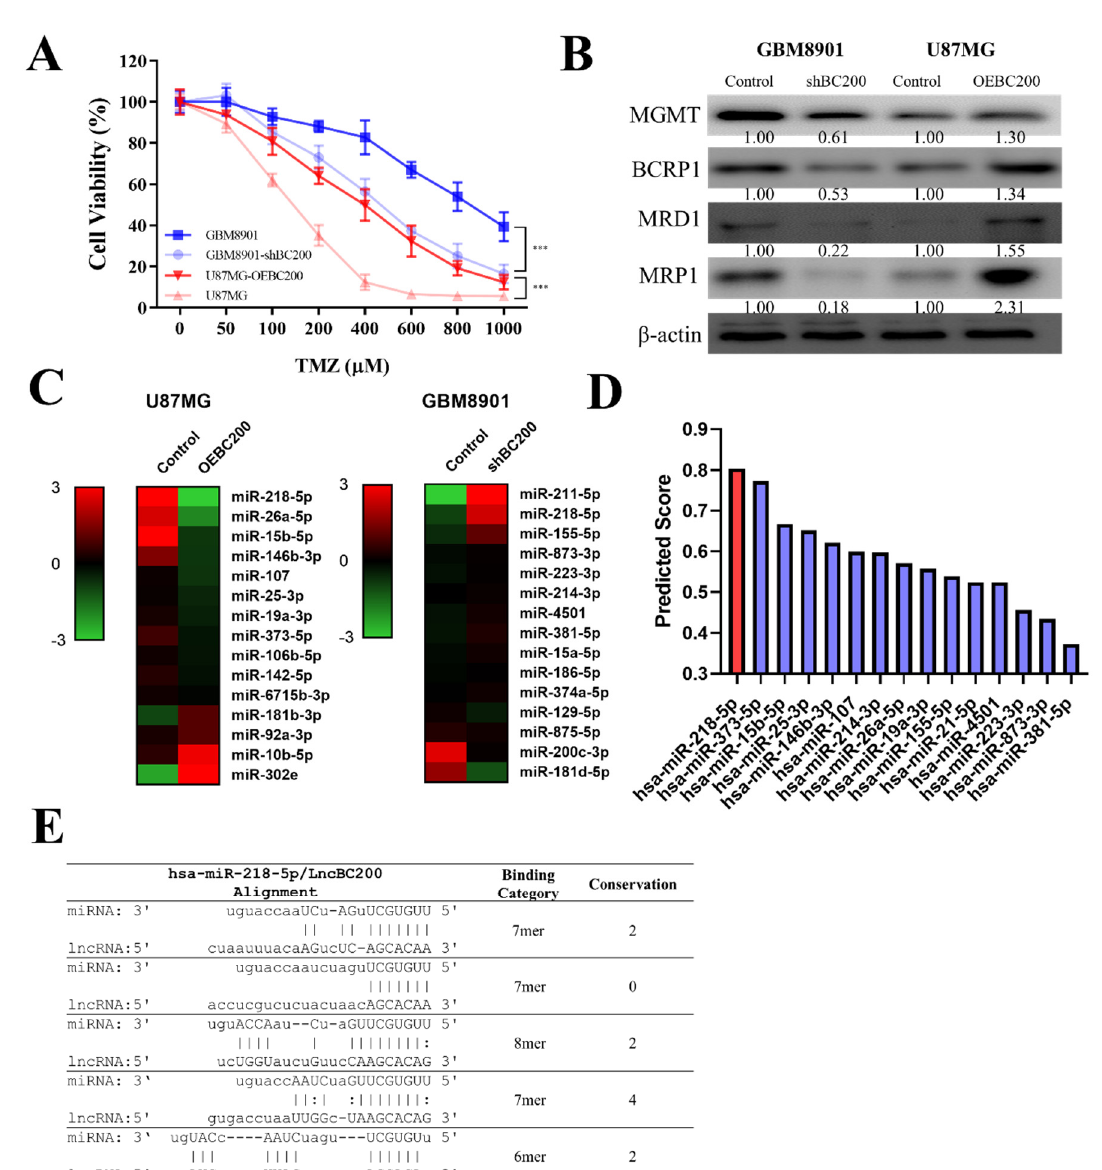
Figure 5. BC200 RNA promotes TMZ resistance in GB through sponge miR-218-5p. ( A ) The viability of shBC200 and OEBC200 GB cell lines was analyzed through SRB assay 48h after TMZ (0–1000 µ M) treatment. ( B ) The levels of MGMT, BCRP1, MDR1, and MRP1 following shBC200 and OEBC200 in GB cells were determined through western blot. ( C ) MicroRNA profiling analyses showed that shBC200 and OEBC200 contained high and low levels of miR-218-5p, respectively. ( D ) LncBase Predicted v.2 predicted that a high binding score of miR-218-5p with BC200. ( E ) BC200 directly interacts with multiple binding sites to hsa-miR-218-5p. *** p < 0.001.